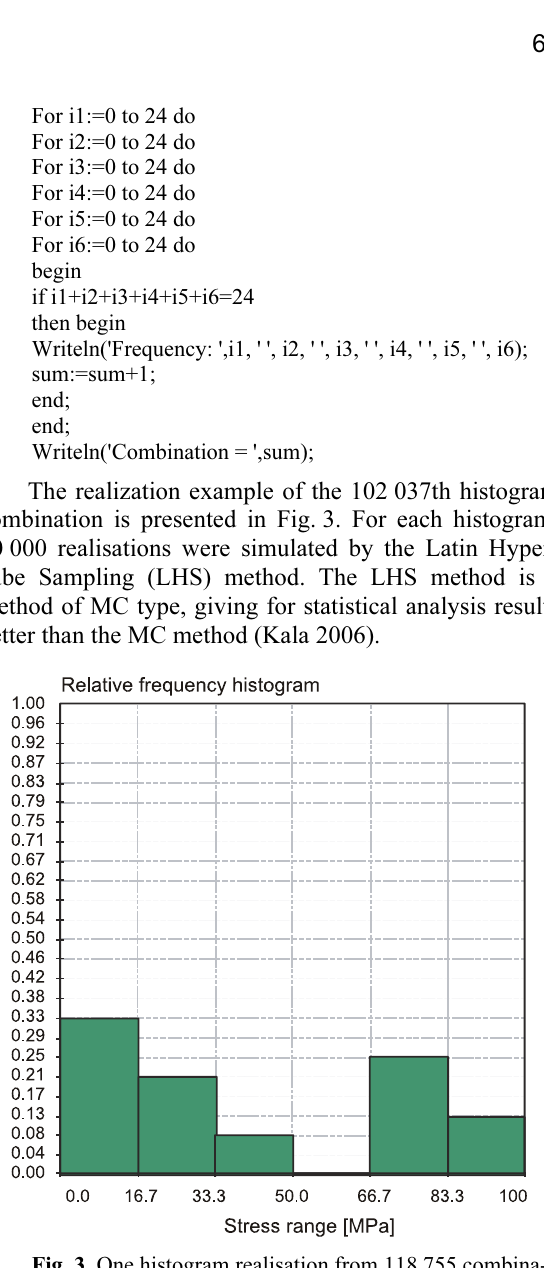
Fig. 3. One histogram realisation from 118 755 combina- tions The processing of 118 755 histograms provided 118 755 files (each file contains N = 10 000 simulated realisations). According to (10), 118 755 random realisa- tions of E Δσ were the computed; one realization E Δσ was computed from (10) with used N = 10 000 simulated